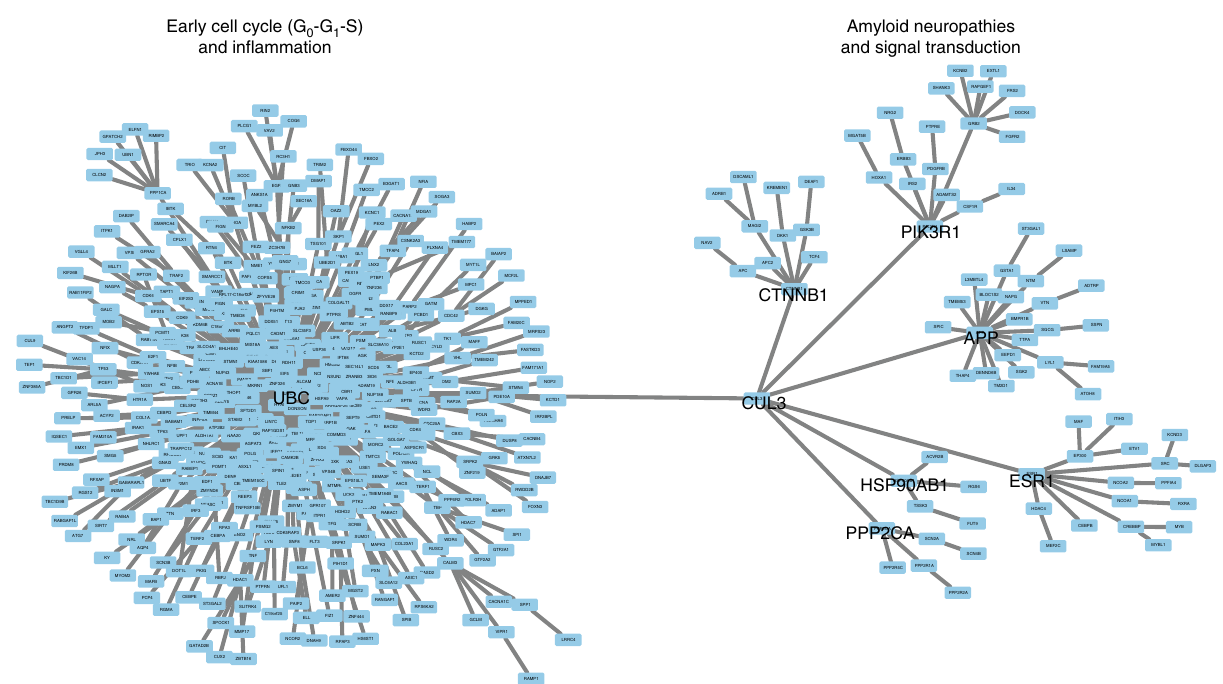
Fig. 3 Omics analysis discovered high-con fi dence networks involved in AD. Using the FOREST OmicsIntegrator 77 , we merged our DNA methylation sequencing dataset pro fi ling enhancers in AD neurons and transcriptomic sequencing data generated from the no/mild, moderate, and severe AD prefrontal cortex (Braak stage 1 – 6). Molecular pathways affected in AD neurons, as determined by network analysis are shown, and highlight two major networks involved in pathological progression in AD neurons. Pathway analysis by MetaCore of these two networks show their primary involvement in cell cycle reentry and amyloid neuropathies, respectively ( q < 0.001, hypergeometric distribution). Hub genes: UBC and CUL3; subnetwork genes connected to CUL3: APP , CTNNB1, PIK3R1, ESR1, HSP90AB1, and PPP2CA are shown in